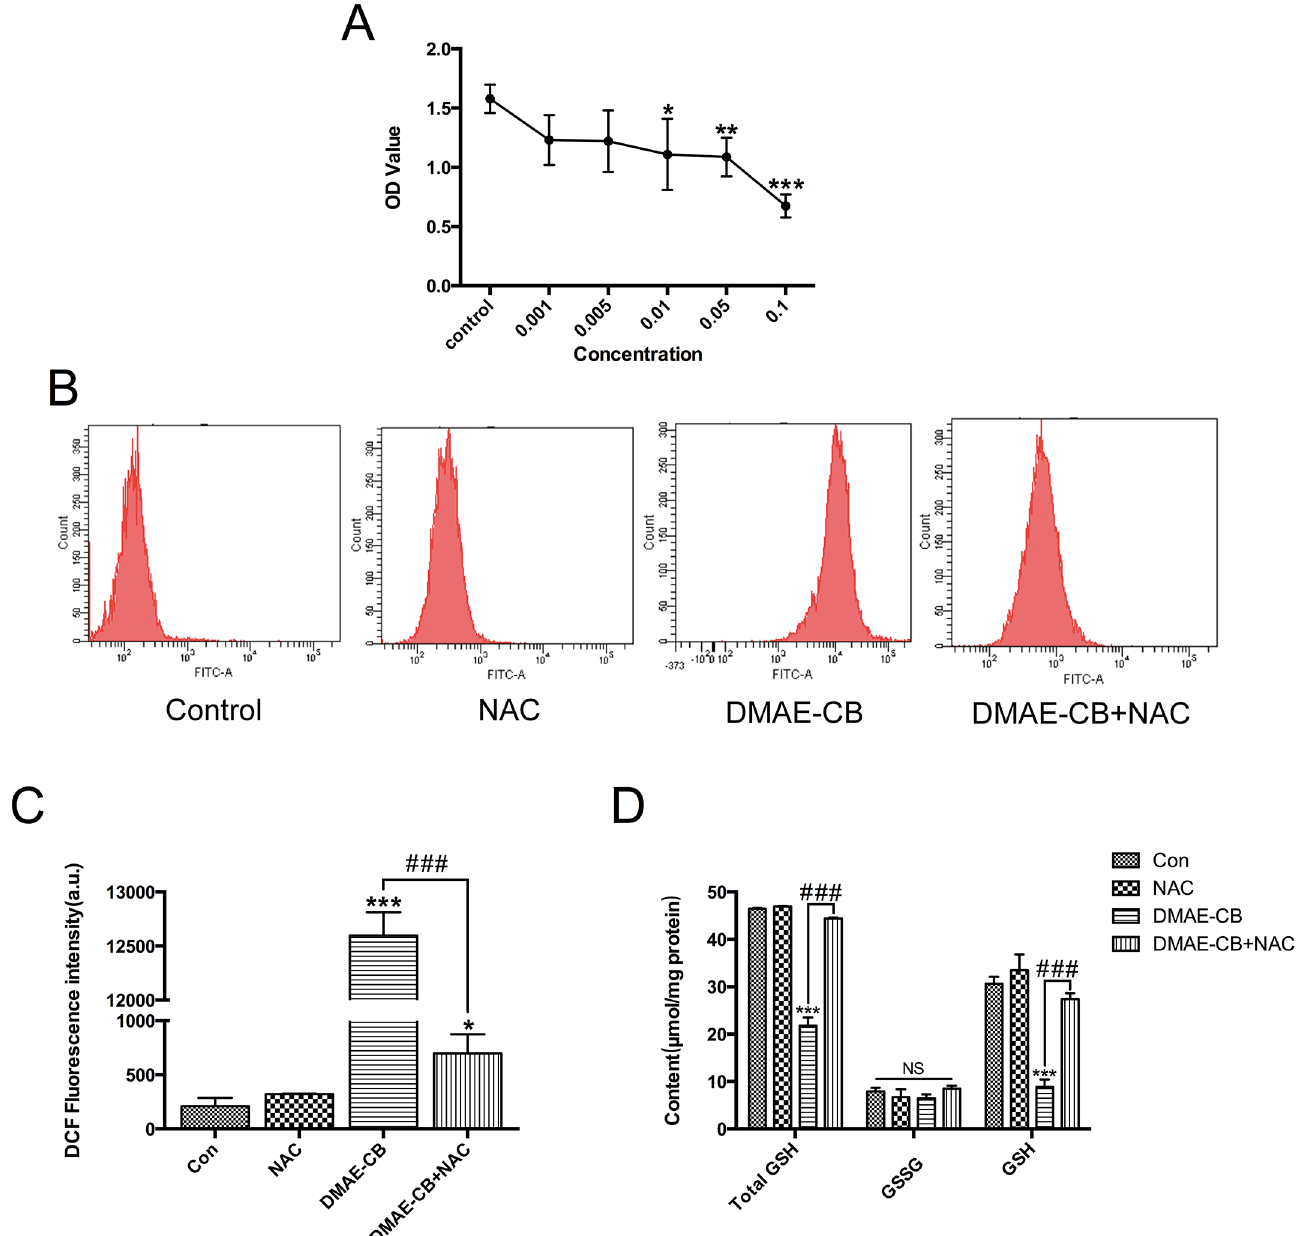
Fig 3. Influence of DMAE-CB on cell viability and oxidative stress and the rescuing effects of NAC. A. Cytotoxicity of DMAE-CB on hDPCs as evaluated by CCK-8 assay (n = 6). B-D. Effects DMAE-CB on intracellular oxidative stress and the rescuing effect of NAC. Intracellular ROS levels (B,C) and contents of GSH (D) in hDPCs were presented, respectively (n = 3). ( * p < 0.05, ** p < 0.01, *** p < 0.001 versus control group; #p < 0.05, ##p < 0.01, ###p < 0.001 versus DMAE-CB-treated cells; one-way